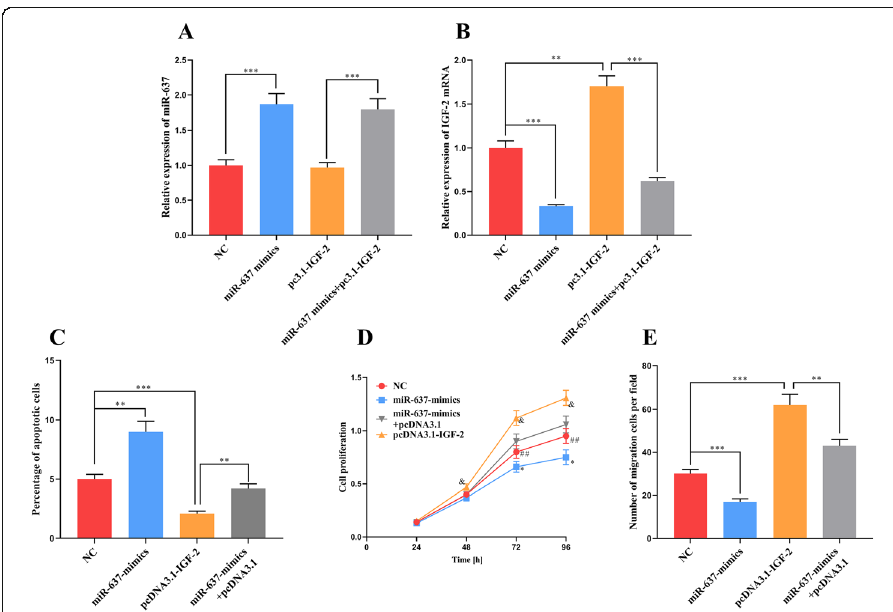
Fig. 4 IGF-2 reverses the effect of miR-637 on the proliferation, migration and apoptosis of VSMCs. a and b – real-time PCR was carried out to determine the expressions of miR-637 ( a ) and IGF-2 mRNA ( b ) in VSMCs after transfection with miR-637 mimics, pcDNC3.1-IGF-2 or miR-637 mimics +pcDNA3.1-IGF-2. c – Flow cytometry was carried out to monitor the apoptosis of VSMCs in each group. d – A CCK8 assay was done to determine the proliferation of VSMCs in each group. e – A Transwell assay was performed to determine the migration of VSMCs in each group. *, **, *** respectively indicate p < 0.05, p < 0.01, p < 0.001. In Fig. D, * indicates p < 0.05, NC group VS miR-637 mimics group; ## indicates p < 0.01, pcDNA3.1-IGF-2 group VS NC group; & indicates p < 0.05, pcDNA3.1-IGF-2 group VS miR-637 + pcDNA-IGF-2 group